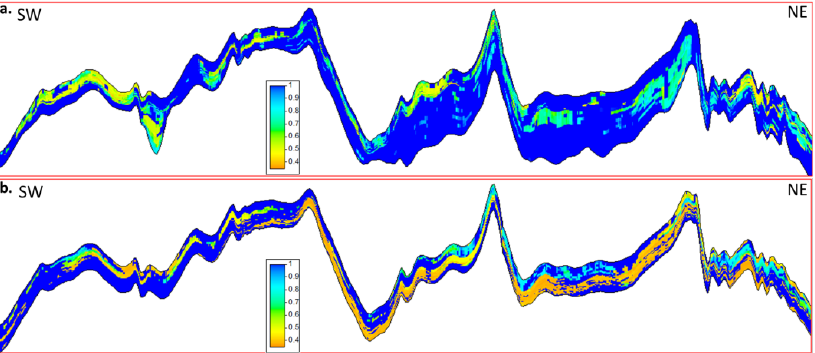
Figure 24. SW–NE intersections of water saturation model of Unit 4 ( a ) and Unit 5 ( b ). The water saturation shows inverse variation trends in Unit 4 and Unit 5. The water saturation has an increasing trend (gas saturation decreasing) from south to north in Unit 4, while it has a decreasing trend (gas saturation increasing) from south to north in Unit 5. Cut-off values from petrophysical analysis are adopted to generate the net to gross (NTG) model. The cut-off values are from two parameters: Vsh and porosity. The NTG